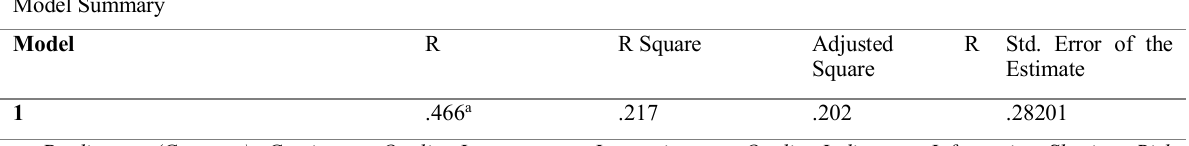
Table 14: Regression model summary for continuous quality improvement